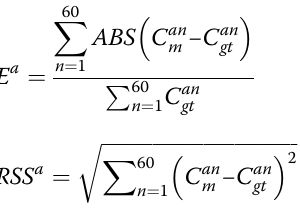
time. In each subgraph, circles without arrows represent ¼ C an , i.e., 100% accurate measure- cases where C an m gt ment. Upward and downward arrows are overcount ( C an m > C an < C an ) and undercount ( C an ) cases, respectively, gt m gt with arrow lengths representing the absolute discrepancy − C an j . By definition, the tip of each computed as j C an m gt arrow is the traffic measurement reading of that sample.